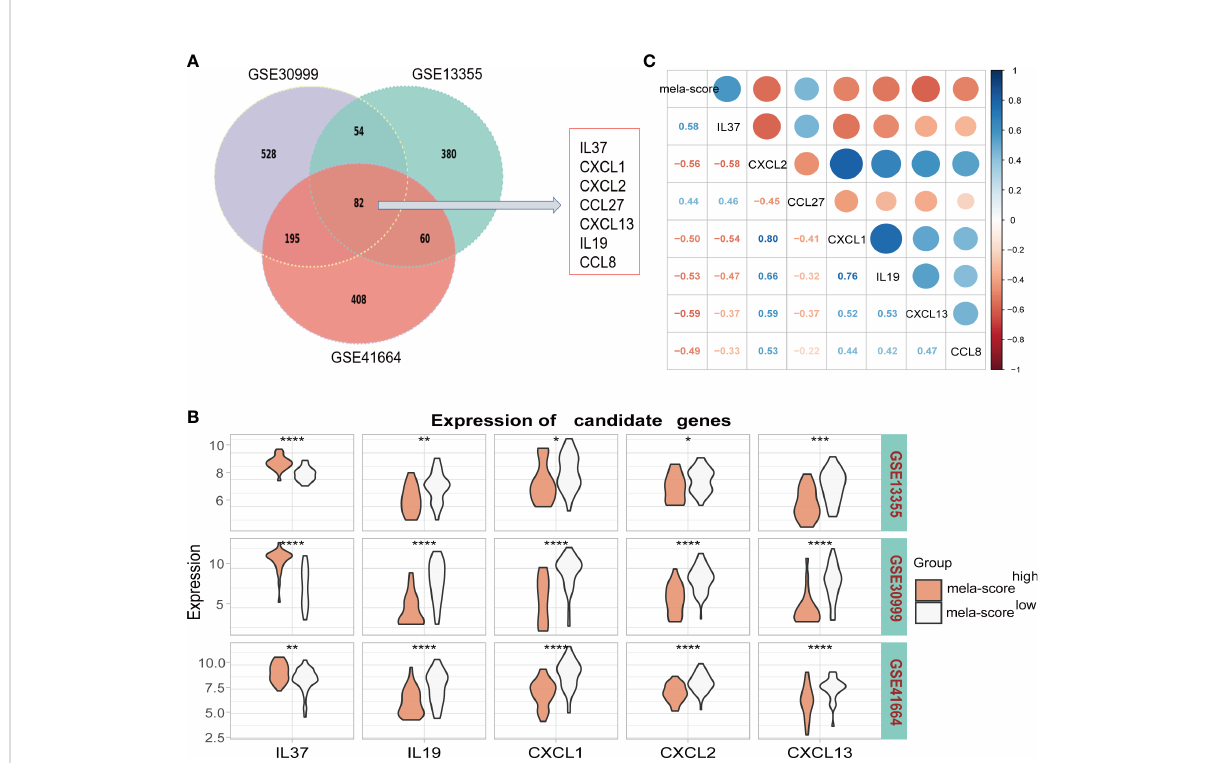
FIGURE 3 Identi fi cation of candidate genes. (A) Seven in fl ammatory genes were screened from the overlapping DEGs of 3 datasets. (B) The mRNA expression levels of 7 candidate genes in the datasets. (C) The correlation between candidate genes and mela-score. *P < 0.05, **P < 0.01, ***P < 0.001,****P <